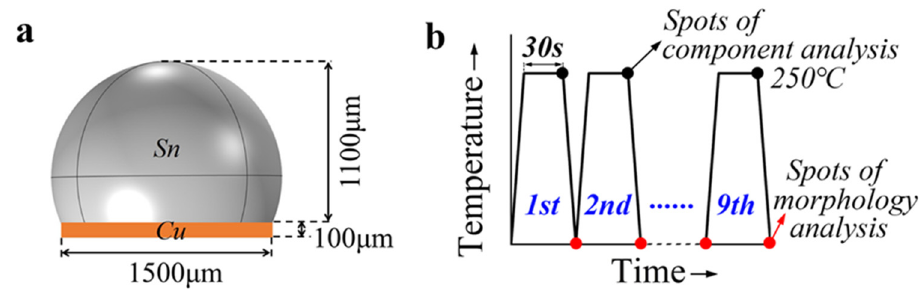
Figure 1. Schematics of the experimental solder bump ( a ) and the temperature profile of the nine-time reflow process ( b ).